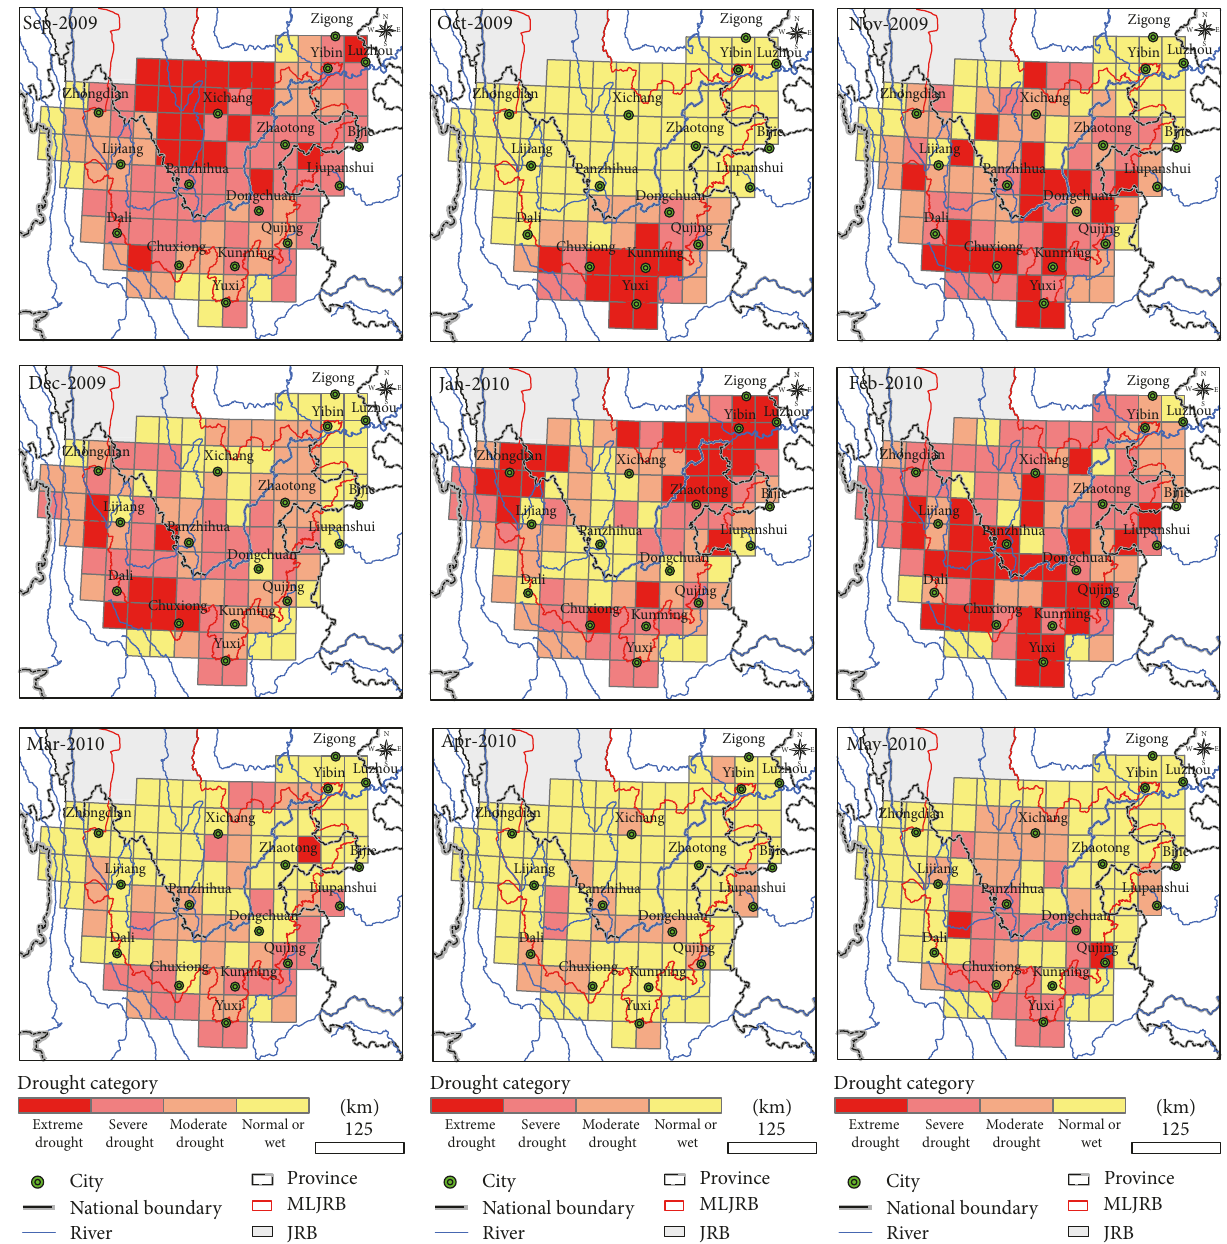
Figure 10: The distributed map of drought category from September 2009 to May 2010 based on modified SSDI.